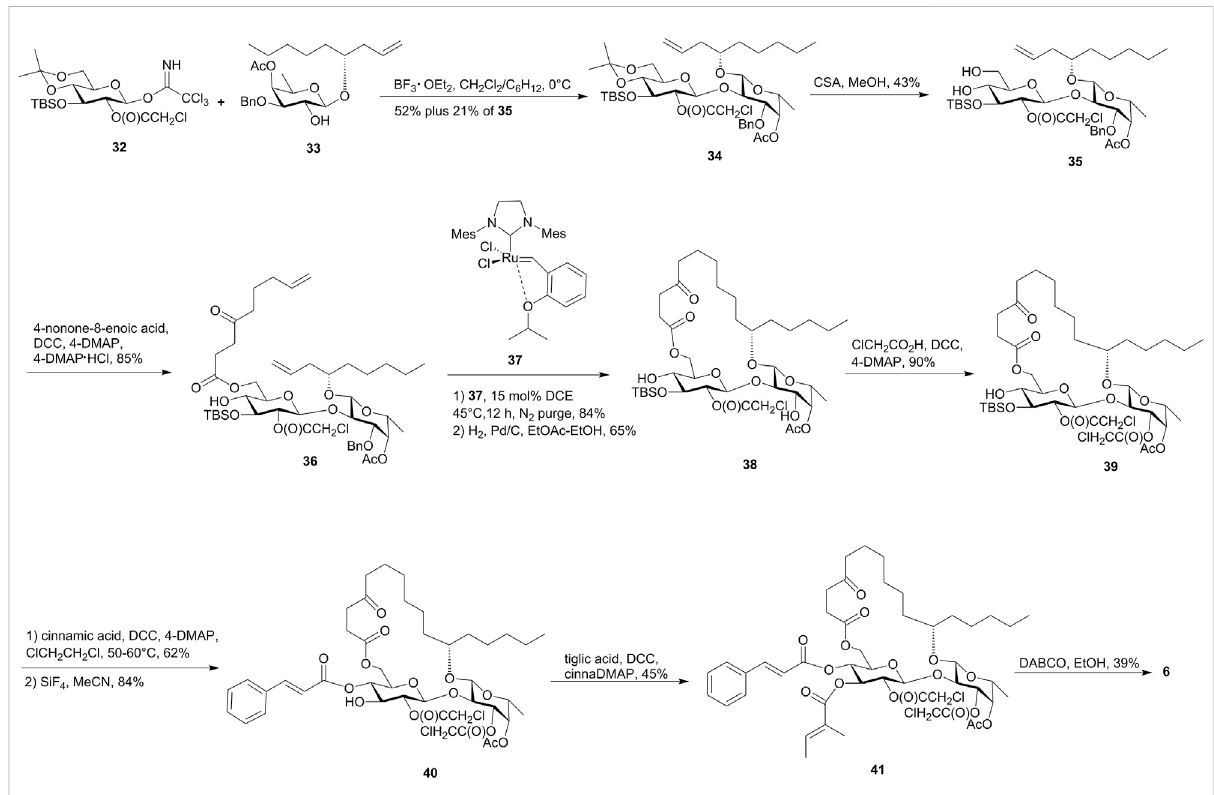
FIGURE 4 Postema ’ s approach toward the synthesis of ipomoeassin F ( 6 ). CSA, camphor-10-sulfonic